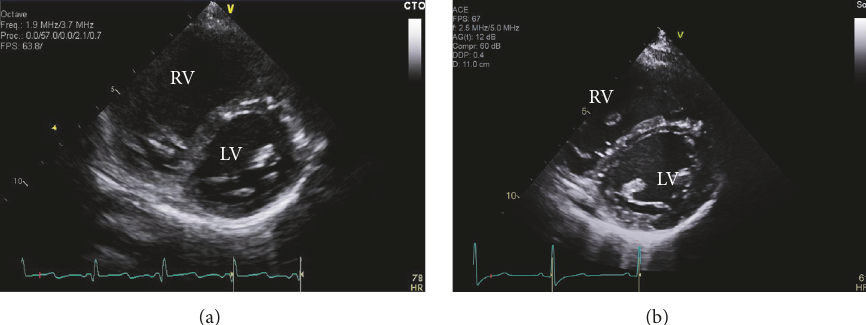
Figure 1: (a) ECHO at diagnosis showing a short access view of the ventricles at systole with interventricular septal thickening and flattening; LV: left ventricle; RV: right ventricle. (b) At follow-up (after treatment); significant improvement in the interventricular septal morphology.